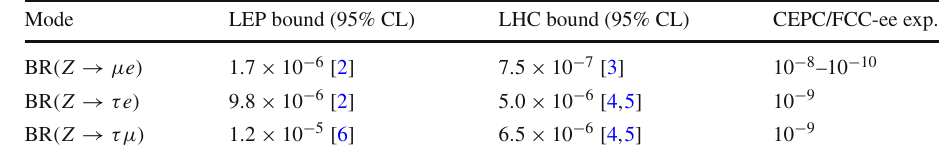
Mode LEP bound (95%